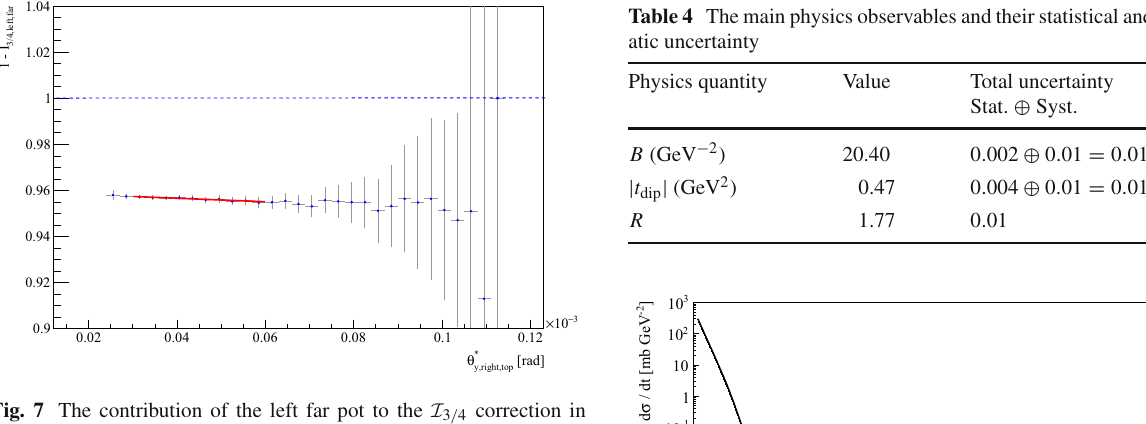
Fig. 7 The contribution of the left far pot to the I 3 / 4 correction in Diagonal 1. The inefficiency as a function of θ ∗ y is estimated with a linear fit, shown with a solid red line Table 3 Corrections to the differential rate for the two diagonals. The “uncorrelated” inefficiency correction ( I 3 / 4 ) is t -dependent, in the table the average correction on the elastic rate is provided Correction Diagonal 1 Diagonal 2 . 2 ± 1 . 1 12 . 25 ± 1 . 4 I 3 / 4 (%) 11 Fig. 8 Differential elastic cross-section d σ/ d t at statistical and | t | -dependent correlated systematic uncertainty envelope is shown as a yellow